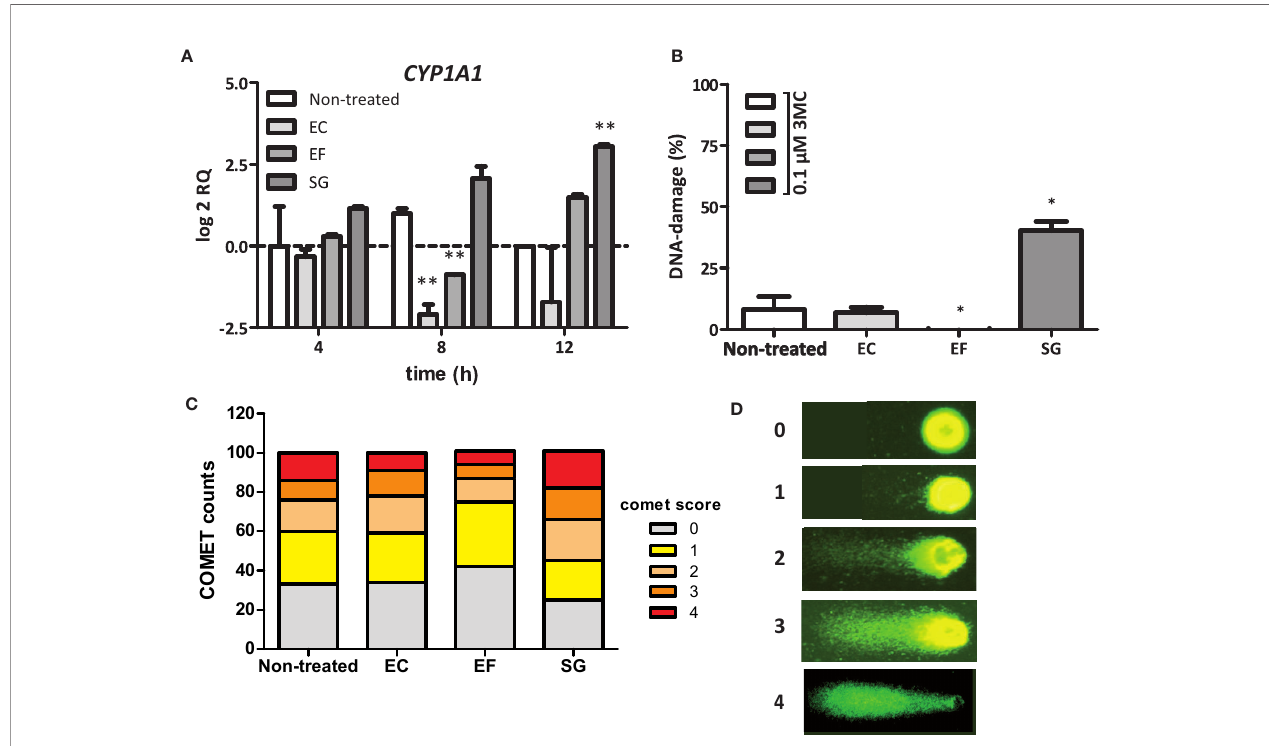
FIGURE 4 | SGS induced CYP1A1 expression and increase in the DNA-damaging effect of 3MC. (A) Expression of CYP1A1 in Caco-2 cells was examined by qPCR after exposure of these cells to the secretomes of E. coli NTB 5 (EC), S. gallolyticus UCN34 (SG), and E. faecalis 19433 (EF). Note that only exposure to secretomes from S. gallolyticus UCN34 resulted in increased CYP1A1 levels after 8 and 12 h (**p < 0.01). (B) DNA damage under the conditions described in Panel (A) were measured by the COMET assay (*p< 0.05). To induce low levels of DNA damage, incubation was prolonged for 18 h after addition of 0.1 µM 3MC to the culture medium. Reference ranges were determined by the incubation of Caco-2 cells without 3MC (0% damage) and with 100 µM H 2 0 2 (100% damage). Only exposure to SGS from S. gallolyticus UCN34 in combination with 3MC yielded increased levels of DNA damage compared to 3MC alone (non-treated). (*p < 0.05) (C) The increase in DNA damage by SGS in combination with 3MC is mainly due to an increased number of cells with DNA damage and with high levels of DNA damage (COMET scores 3 and 4). Two-way-ANOVA (p < 0.01). (D) Representative fl uorescence microscope images with assigned COMET scores used for the quanti fi cation of DNA damage as shown in (B, C)